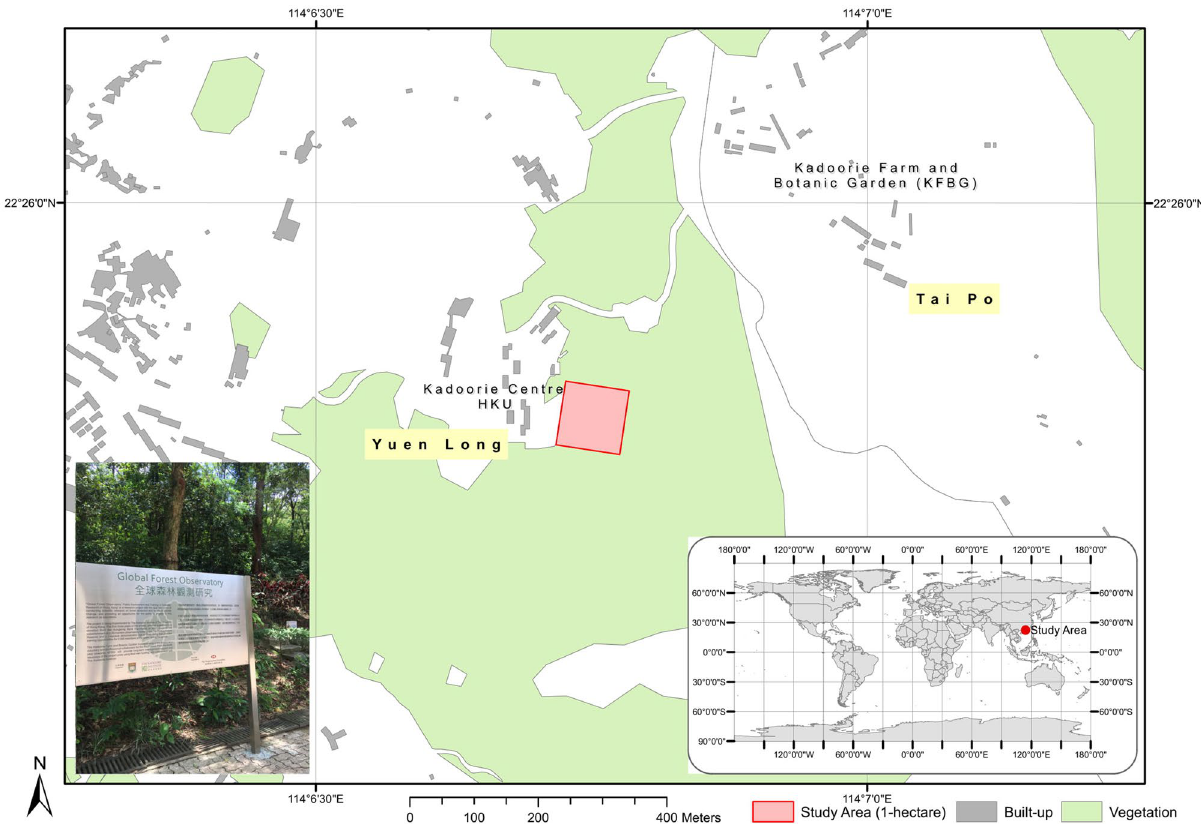
Figure 1. The study area: 1 hectare subtropical moist young forest plot, a full demonstration plot of the Forest Global Earth observatory (ForestGEO) project (https ://fores tgeo.si.edu/), located in Hong Kong in understanding the long-term forest dynamic. The map is generated by Authors using ArcMap version 10.5 (https ://deskt op.arcgi s.com/en/arcma